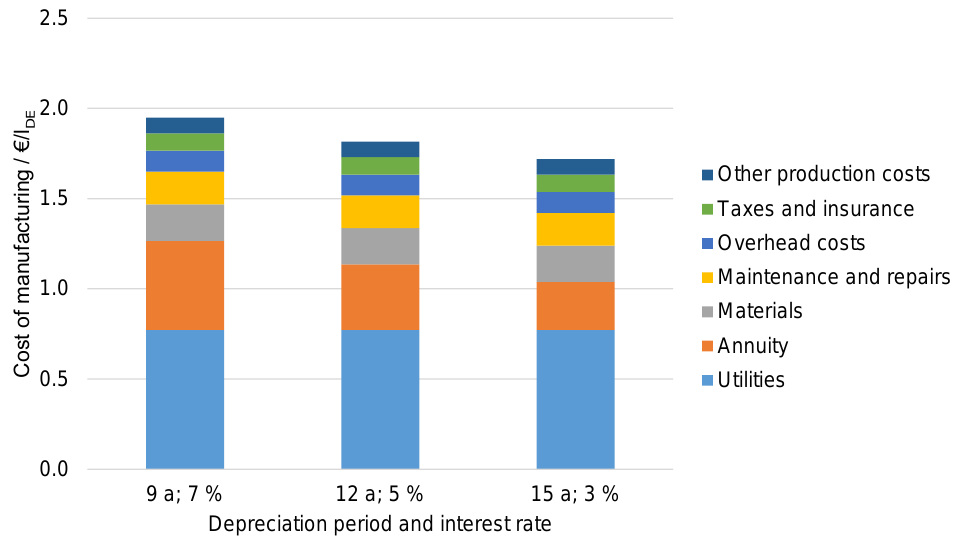
Figure 19. Product production costs depending on the depreciation period and interest rate.